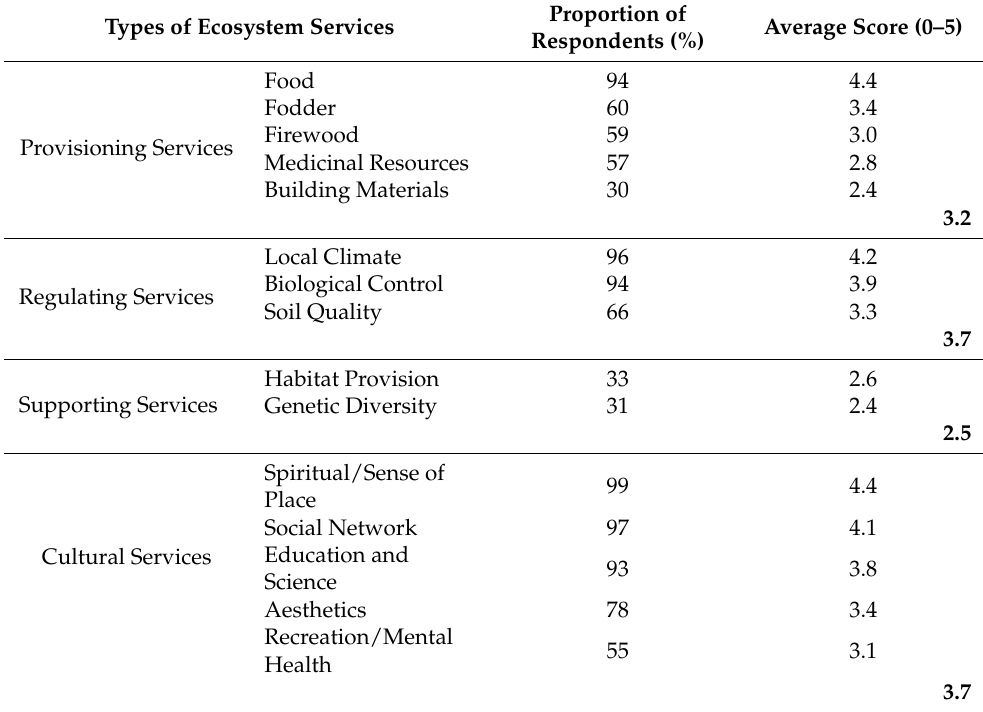
Table 3. Ecosystem services prioritized by stakeholders in health clinic